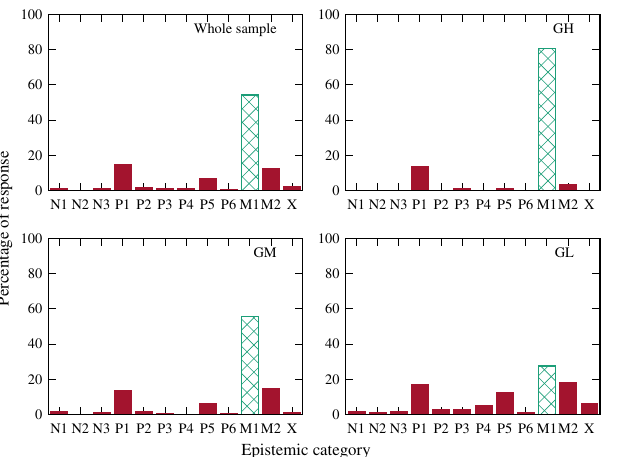
FIG. 13. Aggregate distribution of responses to all proposi- tions (S12, S16, S21, S26, S30, S31, S33, S34, S36) corre- sponding to epistemic category M2. Format of the figure is the same as in Fig.